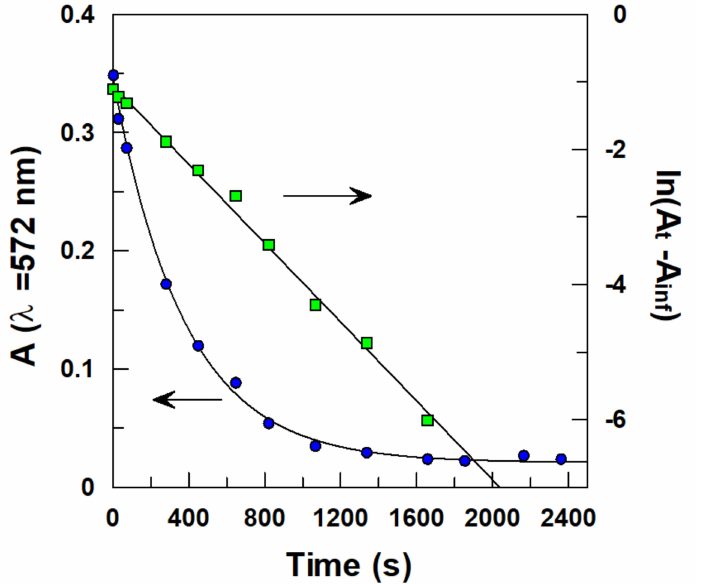
Figure 1. Representative kinetic obtained in corn oil emulsions showing the first-order decrease in the absorbance ( λ = 572 nm) of the formed azo dye with time (Scheme 5). The linear variations of ln(A t -A inf ) with time were used to determine k obs values for the reaction between 16-ArN 2+ and the antioxidants. The solid lines are the theoretical curves obtained by fitting the (A, t) and (ln(A t -A inf ), t) pairs of data to the integrated and linearized first-order equations. Runs were carried out in the intact emulsions in triplicate, and the average values (deviations less than 6%) were used in calculations. Experimental conditions: 4:6 stripped corn oil/Tween 20/acidic water (citrate buffer 0.04M, pH 3.65) emulsions, Φ I = 0.0084, [16-ArN 2+ ] = 1.0 × 10 − 4 M, [TC] = 2.0 × 10 − 3 M, T = 25 ◦